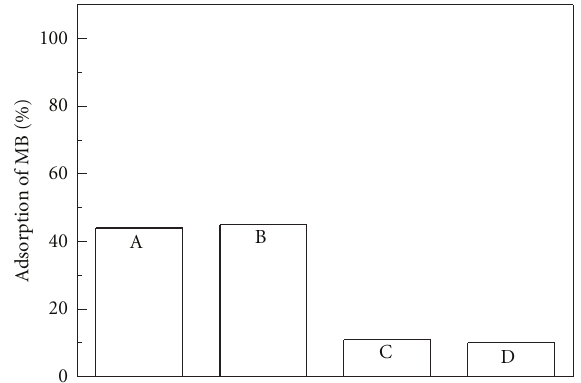
Figure 8: The absorption capacity of (A) C-TiO 2 (UV), (B) C- TiO 2 (200), (C) TiO 2 (500), and (D) N-TiO 2 for MB. photocatalysis, under visible light ( λ > 420 nm) irradiation.